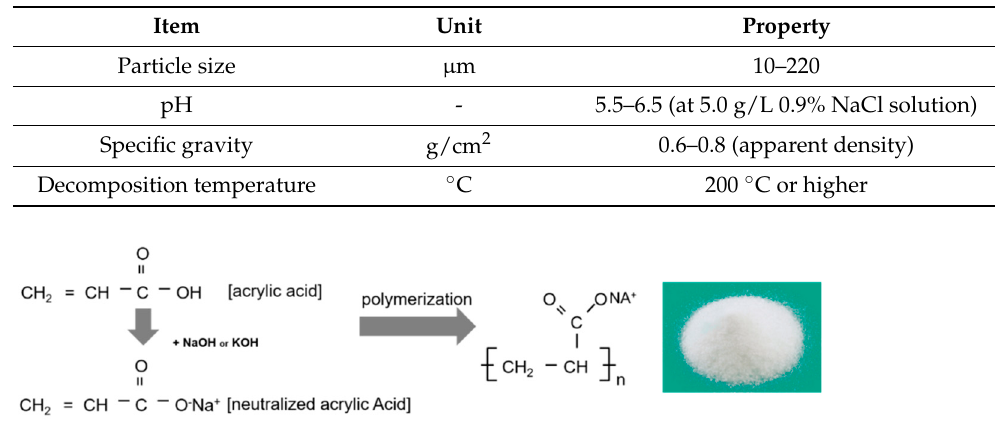
Figure 2. The molecular structure of superabsorbent polymers.